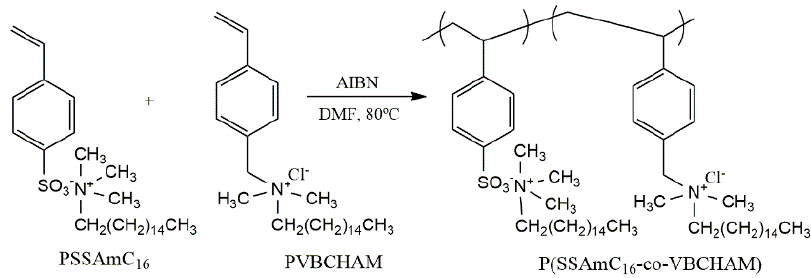
Scheme 2. Mechanism for the synthesis of P(SSAmC 16 - co -VBCHAM x ) copolymers [129].